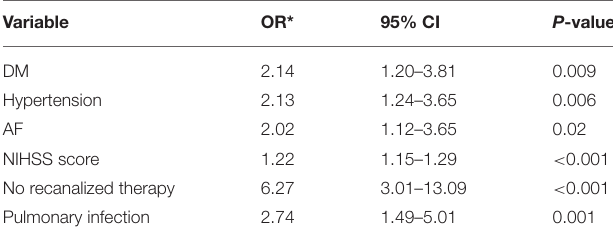
TABLE 2 | Multivariable analysis of the unfavorable outcomes.